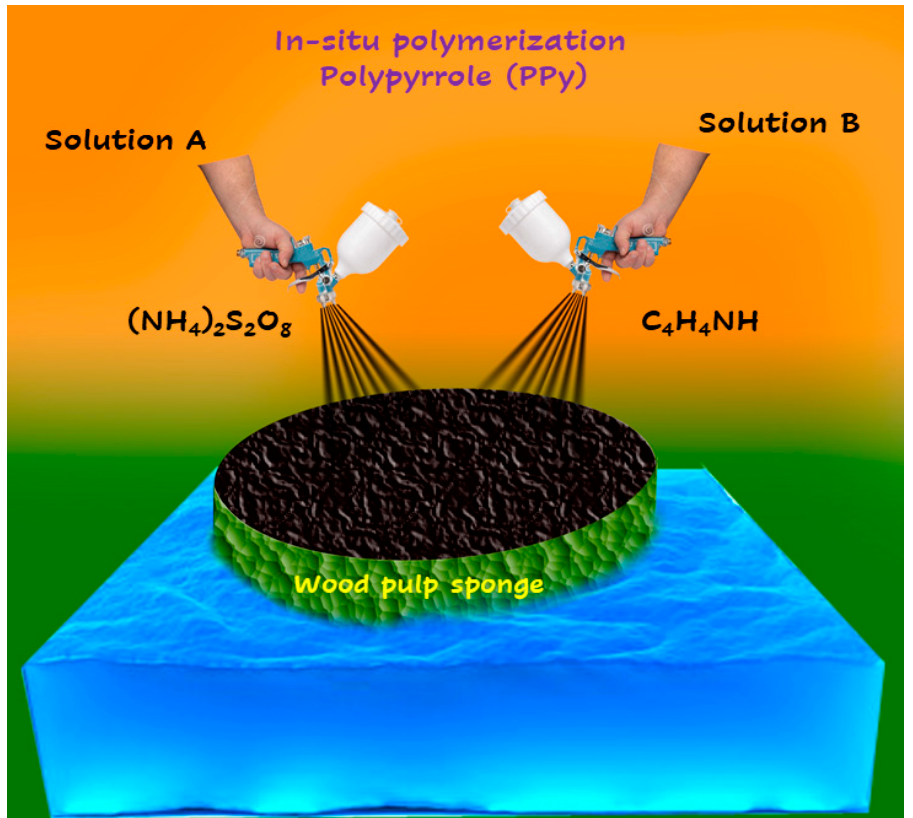
Figure 1. Schematic illustration of simplistic in situ polymerization of PPy nanoparticles over super hydrophilic wood sponge for solar ‐ driven desalination.